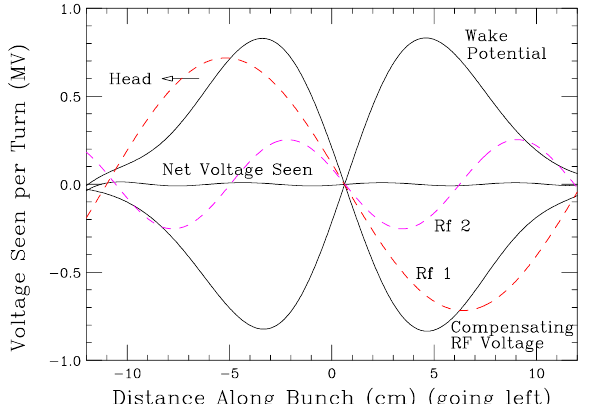
FIG. 1. (Color) Wake potential, compensating rf voltages, and net voltage seen by particles in the 4-cm bunch at injection. The compensating rf is the sum of two rf’s represented by red dashed lines and magenta dashed lines. spread is only 60